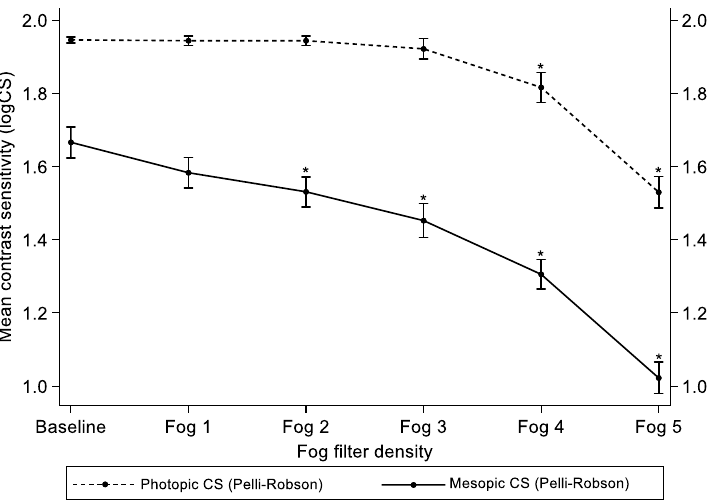
Figure 3. Mean photopic and mesopic CS at baseline and under different Fog filter conditions as measured with the Pelli-Robson chart. Error bars are 95% confidence interval of means. * = p < 0.001 and represents significant difference in CS at baseline compared with Fog filters 4 and 5 under photopic conditions and 2–5 under mesopic conditions.